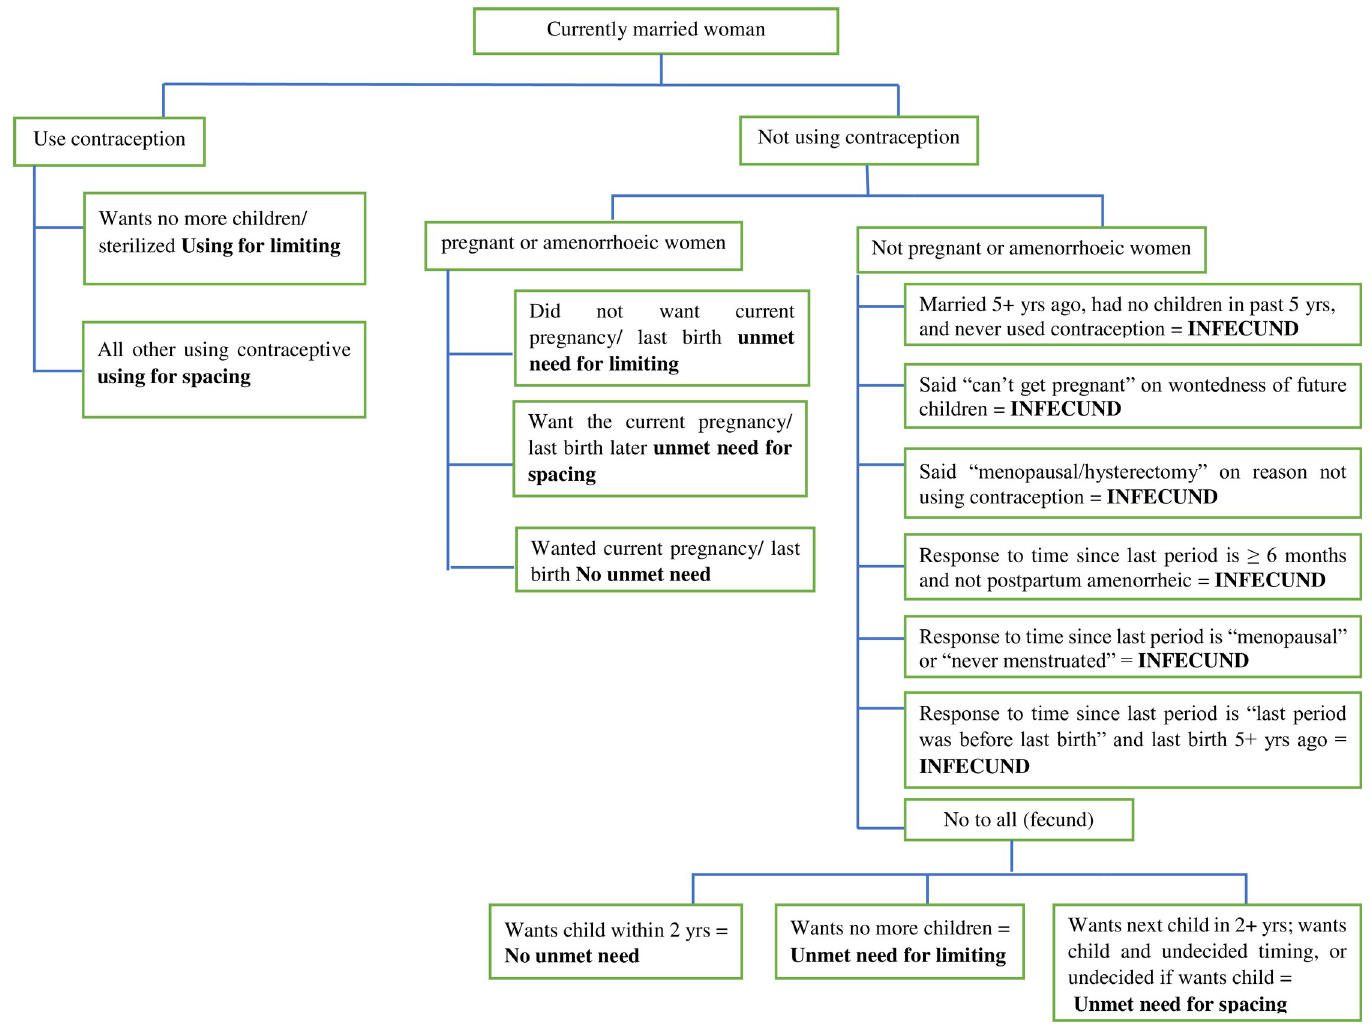
Fig 1. Revised unmet need